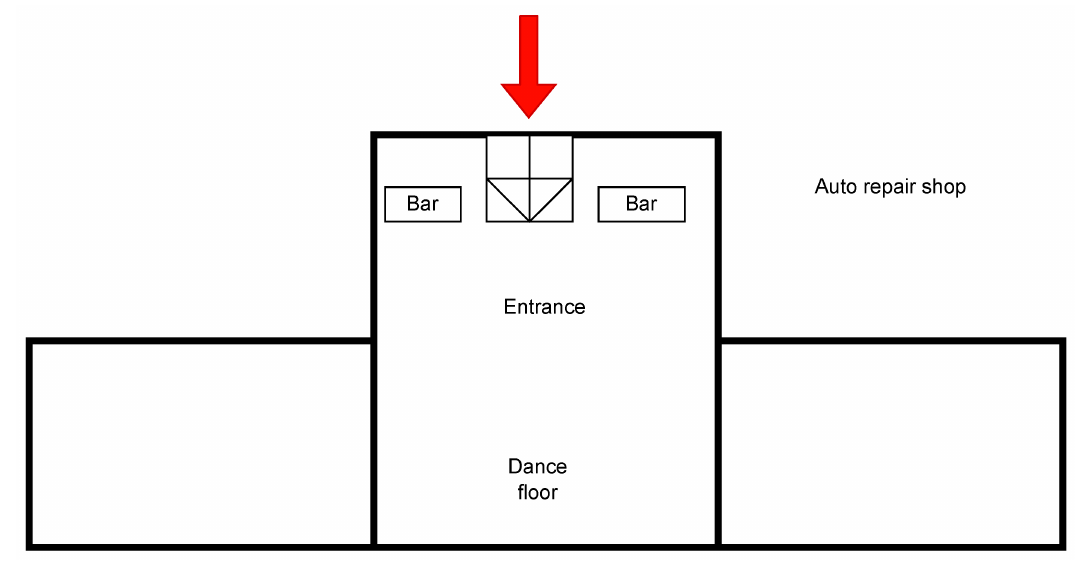
Figure 3. Rough floorplan of El Hoyo (Source: Susan Brandt, from description by Captain Gallagher of the FDNY 56